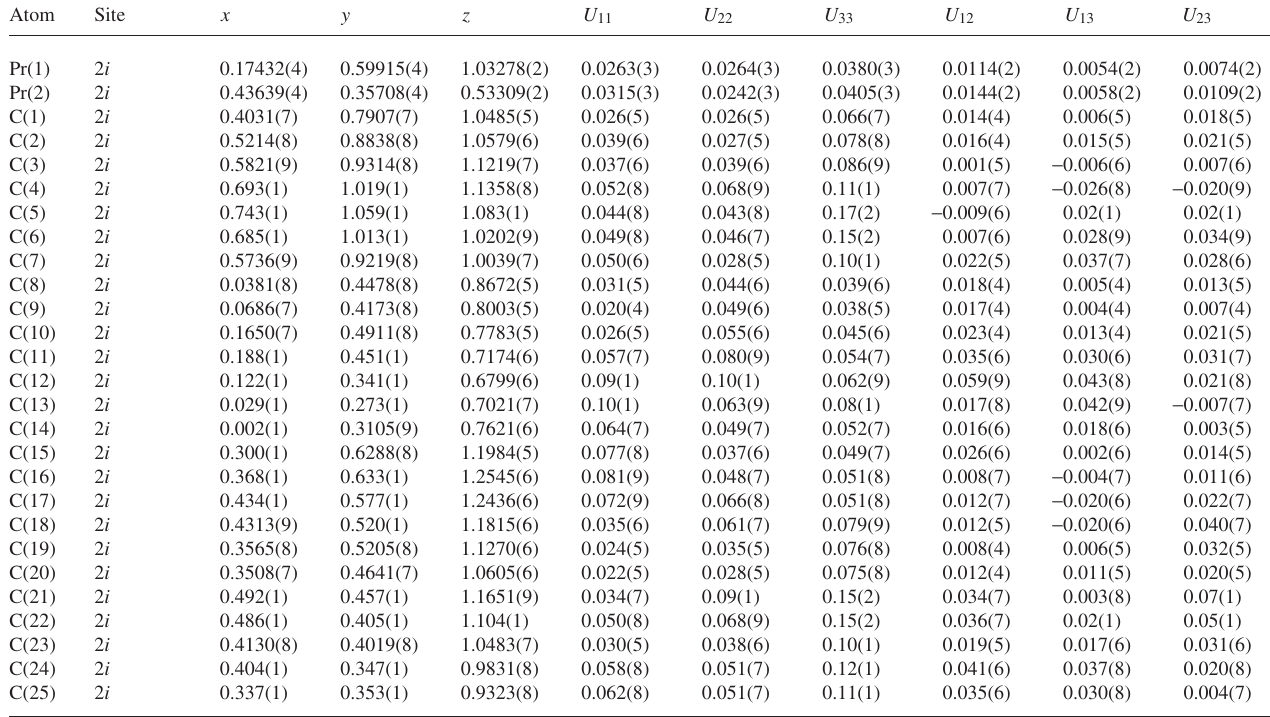
Table 3. Atomic coordinates and displacement parameters (in Å 2 ) .